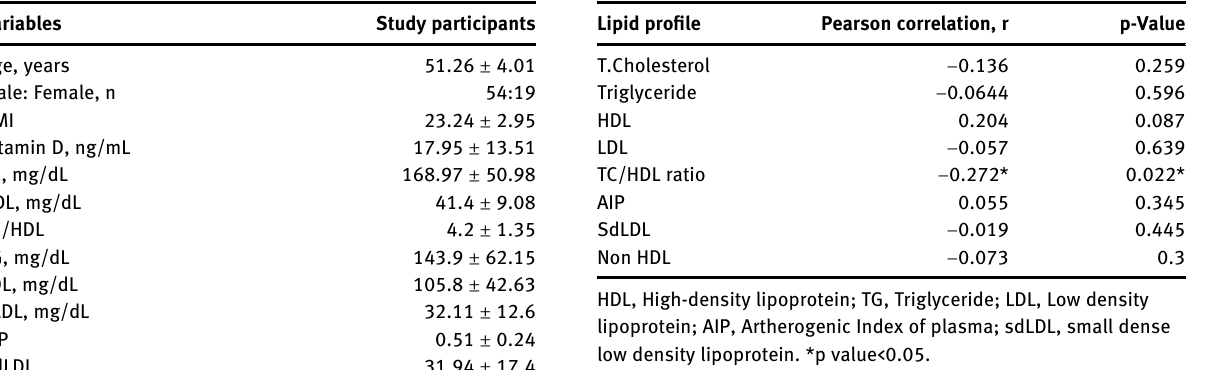
Table  : Correlation of vitamin D with lipid pro fi le among study participants.